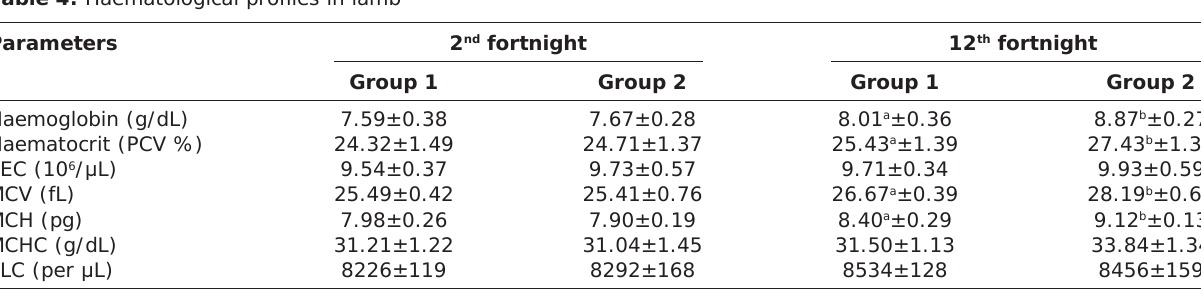
Table 4: Haematological profiles in lamb Parameters